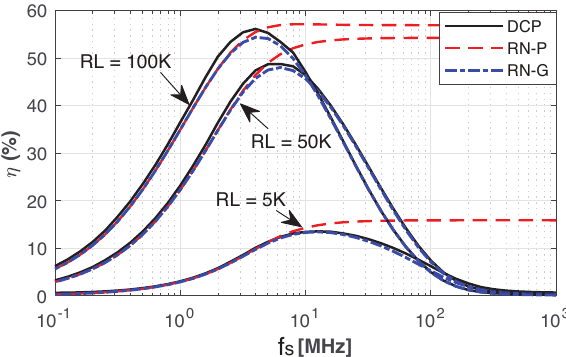
Figure 17. SPICE simulation of the power efficiency vs. f s at different loads for the switching DCP circuit, RN-P, and RN-G